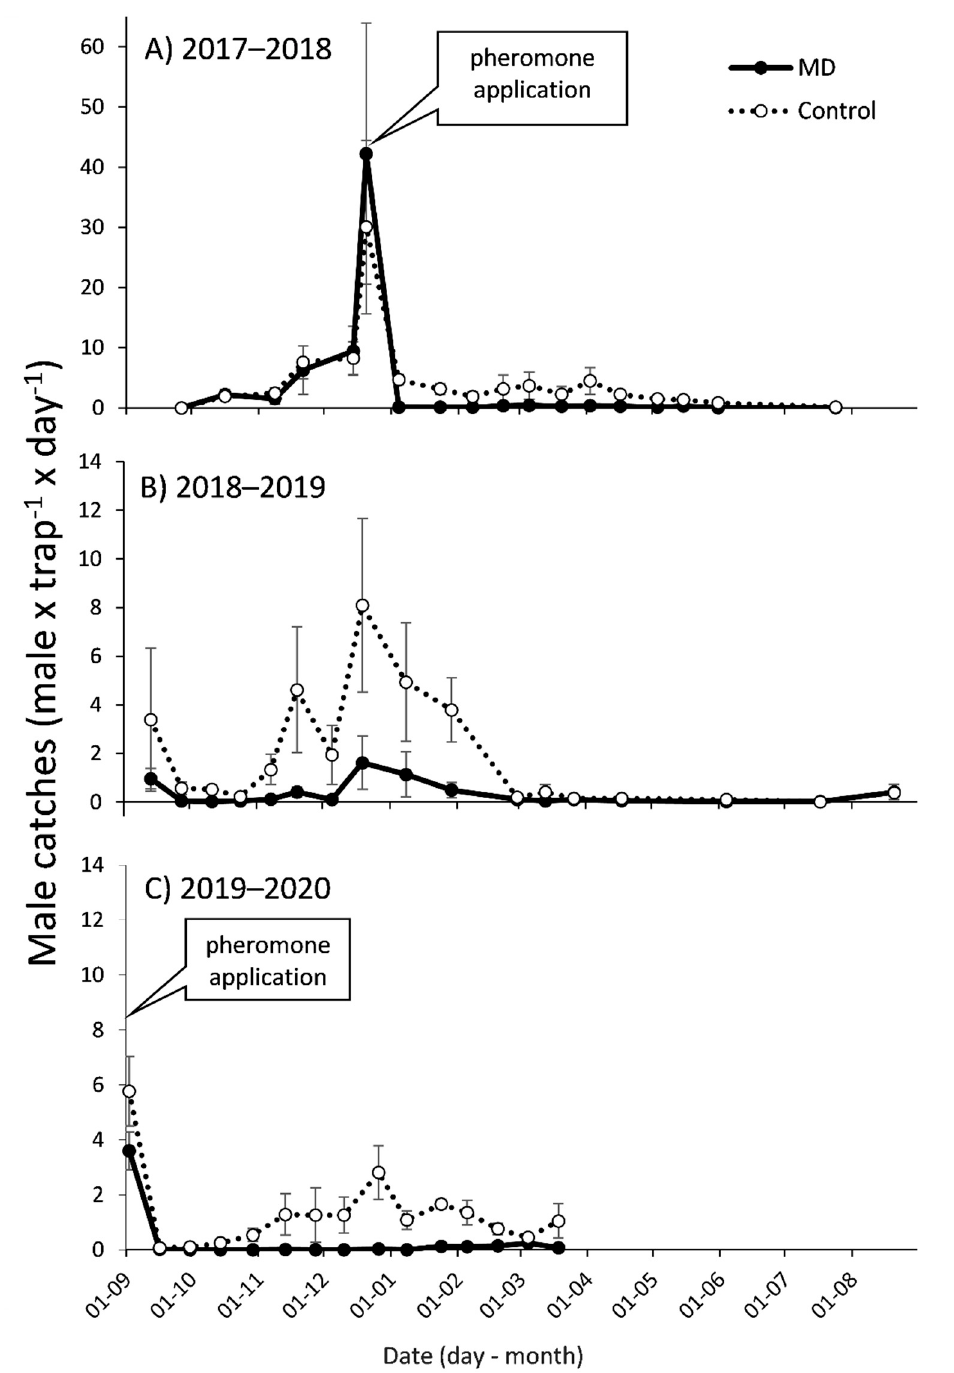
Figure 1. Season long adult male P. calceolariae (mean ± SEM) captures in pheromone baited traps in mating disruption (MD) and control plots in apple orchard from 1 September to 31 August of ( A ) 2017–2018, ( B ) 2018–2019 and ( C ) 2019–2020 seasons. Pheromone application dates: 19 December, 2017 and 29 August, 2019. Note that the scale for the Y axis in the first season differs from the